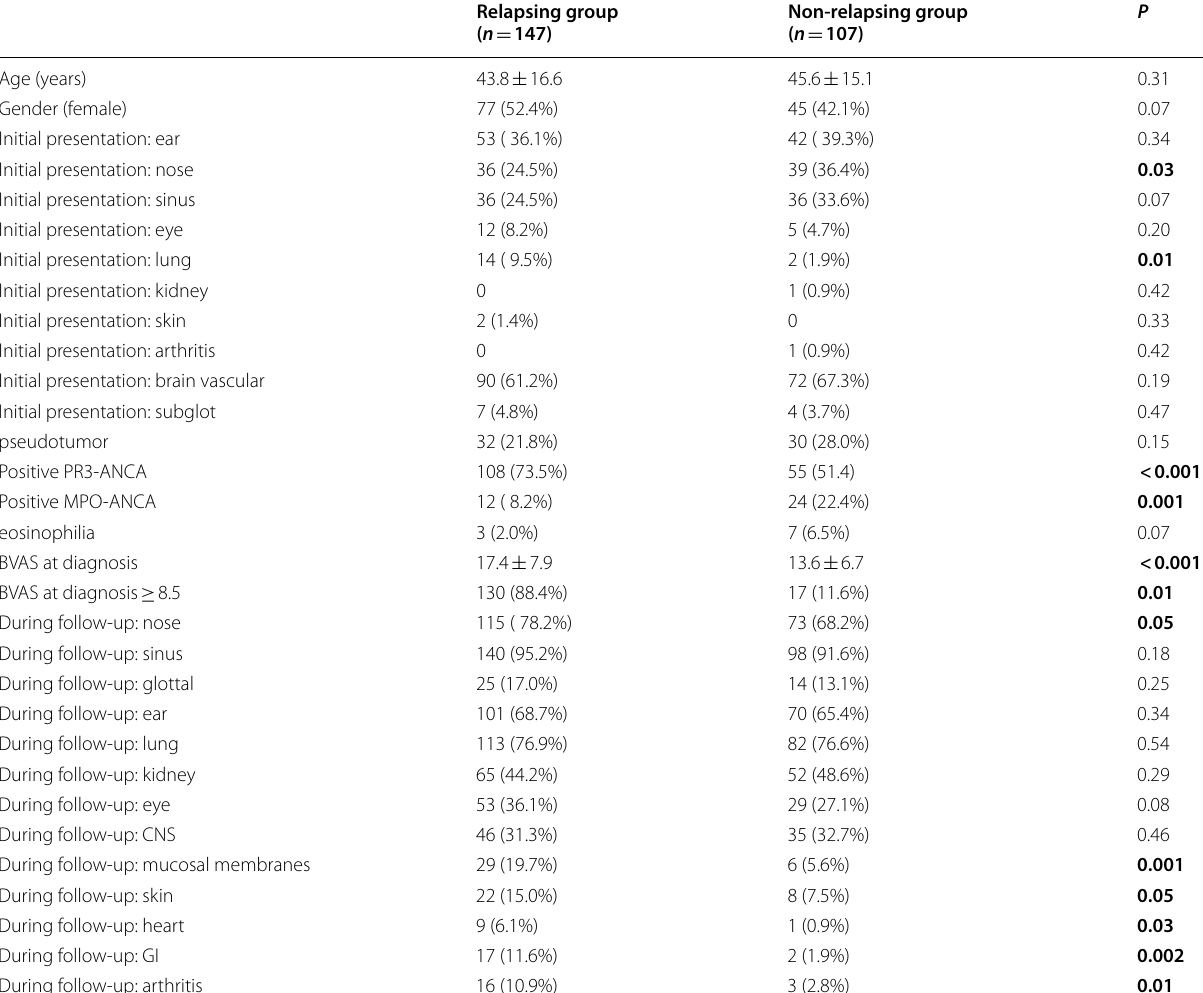
Table 1 Comparison of relapsing and non-relapsing patients